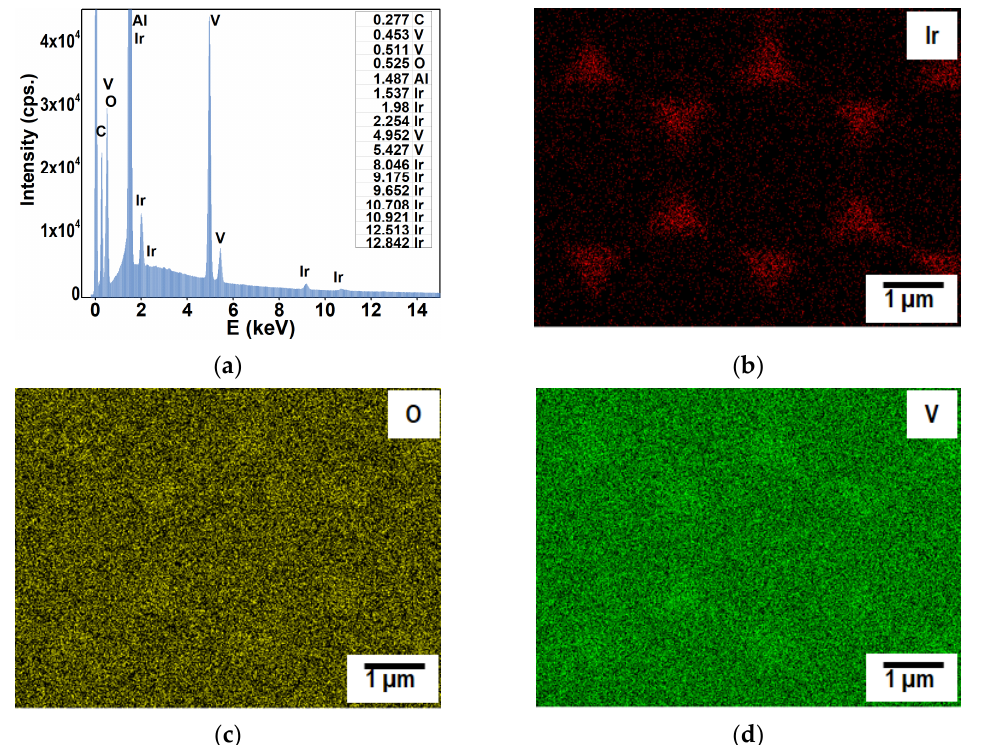
Figure 4. Energy Dispersive X-Ray Spectroscopy and Elemental mapping of a VO 2 –Ir composite. The thickness of VO 2 200 nm and the “a” parameter of Ir microtriangles is equal to 0.70 µm ( a ) EDS elemental analyses of the composite; ( b ) Elemental map of Ir microtriangles; ( c ) Elemental map of Oxygen; ( d ) Elemental map of Vanadium.